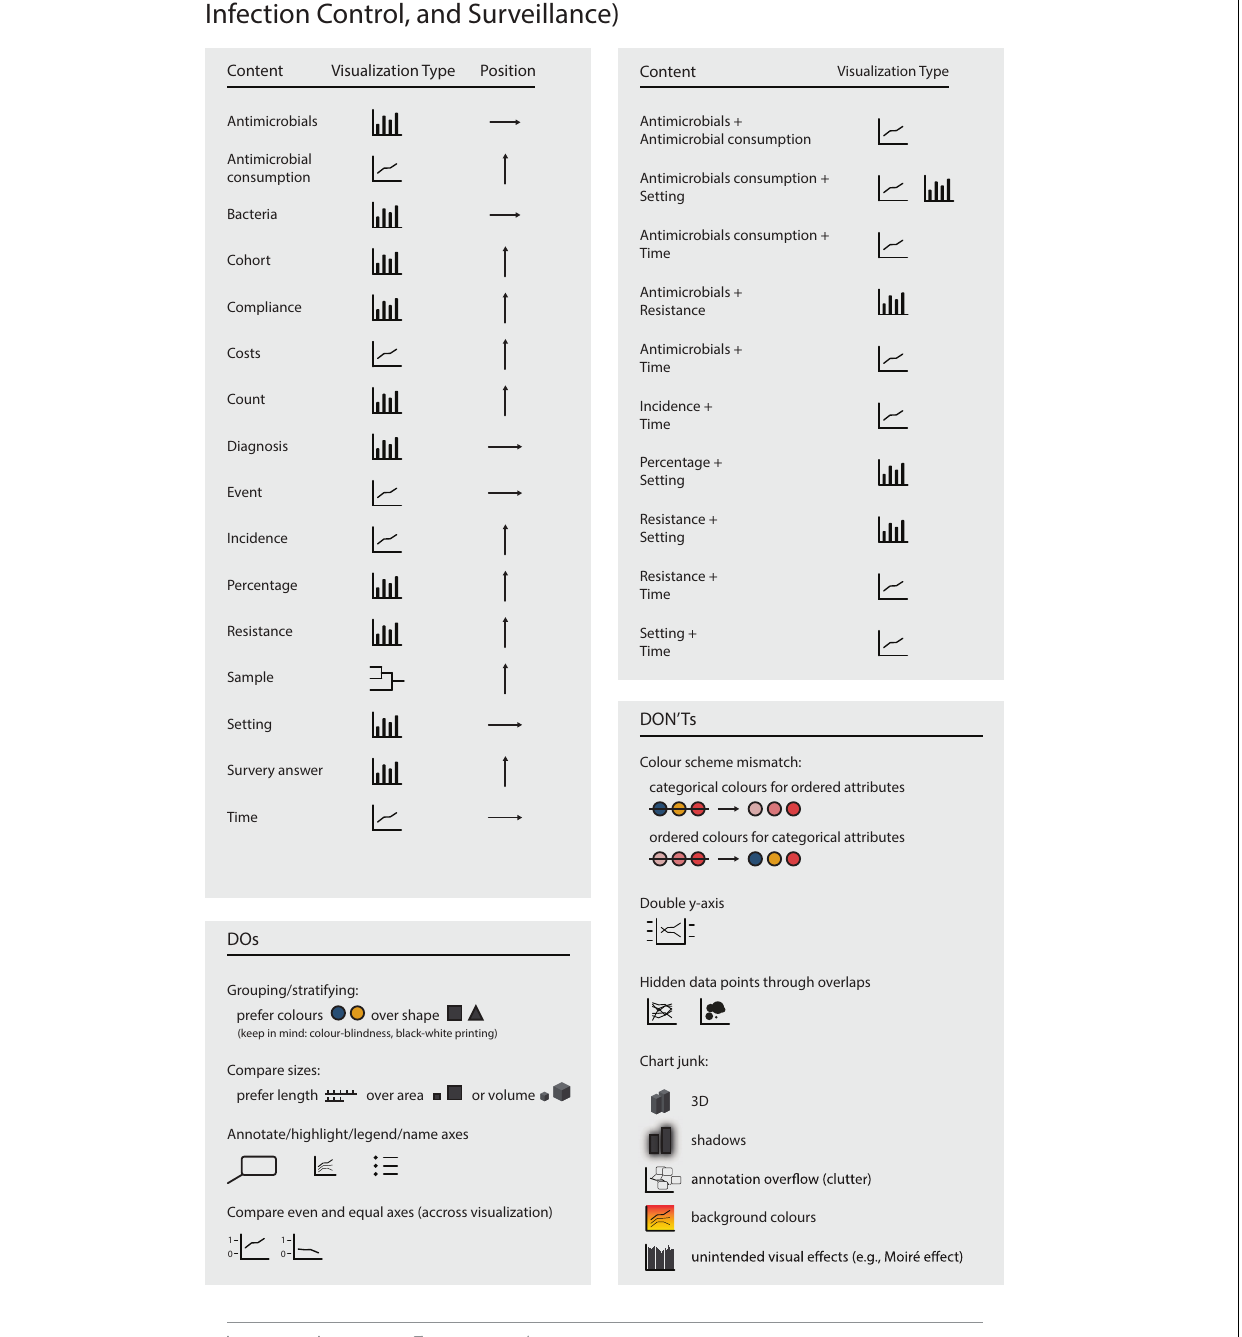
Burggraaff et al., 2021). We see a clear parallel with user- centered eHealth design that emphasizes the need for a holistic understanding of the interrelations between technology,